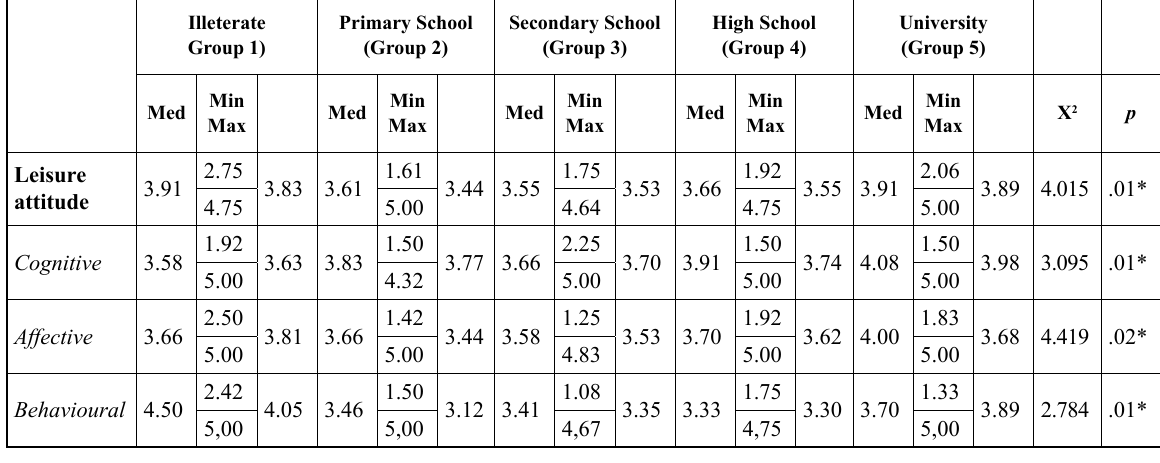
Table 4. Leisure attitude levels of the participants by the variable of educational status